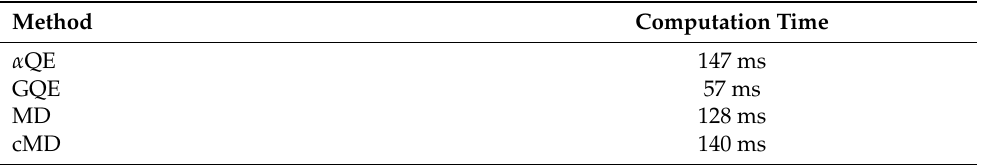
Table 6. Computational overhead of diffusion methods, on ALEGORIA . Experiments made with